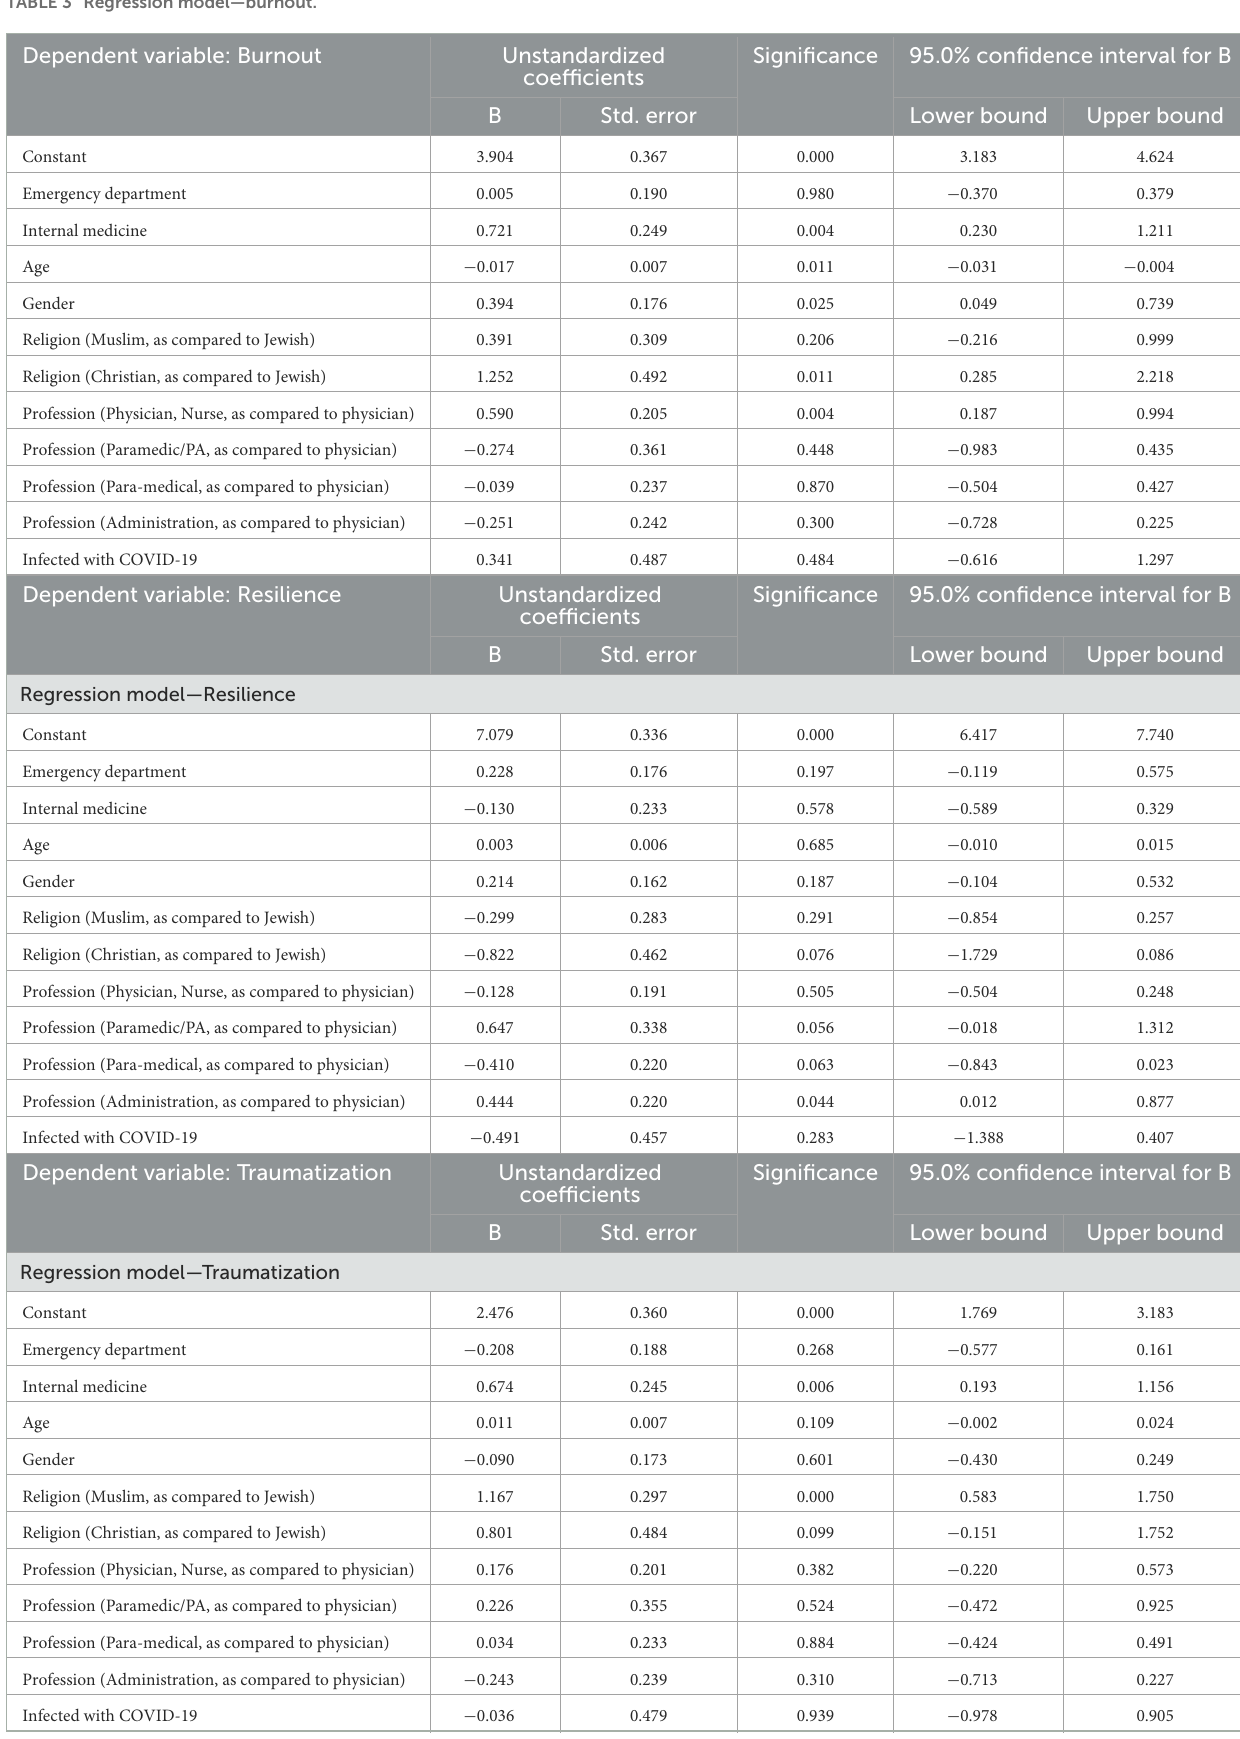
TABLE 3 Regression